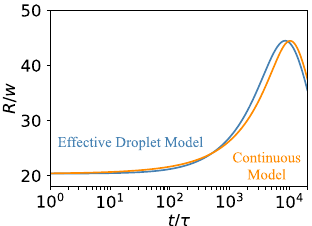
Figure 4. Non-linear growth of a single active droplet. Droplet radius R as a function of time t for the continuous model (orange) and the effective droplet model (blue). The continuous model uses a spherically 0, 100 w symmetric domain with r . The effective model uses a 3-dimensional box of size ∈ [ ] ℓ � s R 0 20 w . Model parameters are s (φ) L 161 w , � x ≈ ≈ ≈ = = k 10 − 4 τ − 1 with a 2 . Remaining parameters are specified in Fig. 2. = =